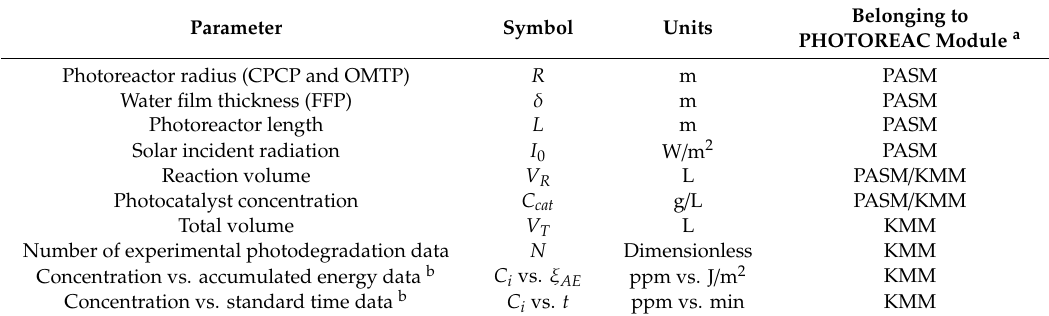
Table 1. Summary of the input information for the PHOTOREAC